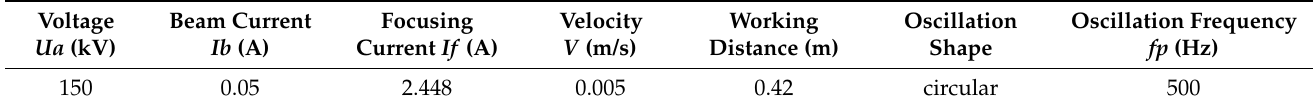
Table 3. Welding parameters.